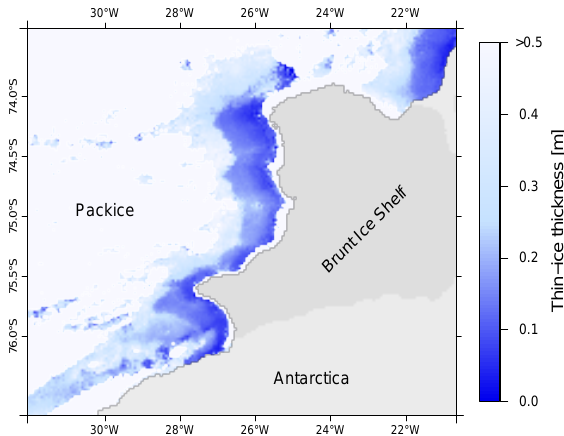
Figure 1. Area of investigation in the Southern Weddell Sea around the Brunt Ice Shelf with example MOD/MYD29-derived thin ice thickness composite (6 September 2012) highlighting the most active polynya areas in the Brunt Ice Shelf